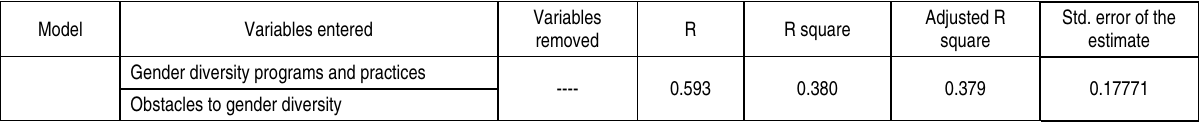
Table 11. Regression model for the independent factor like programs and practices, obstacles to gender diversity on acceptance of gender